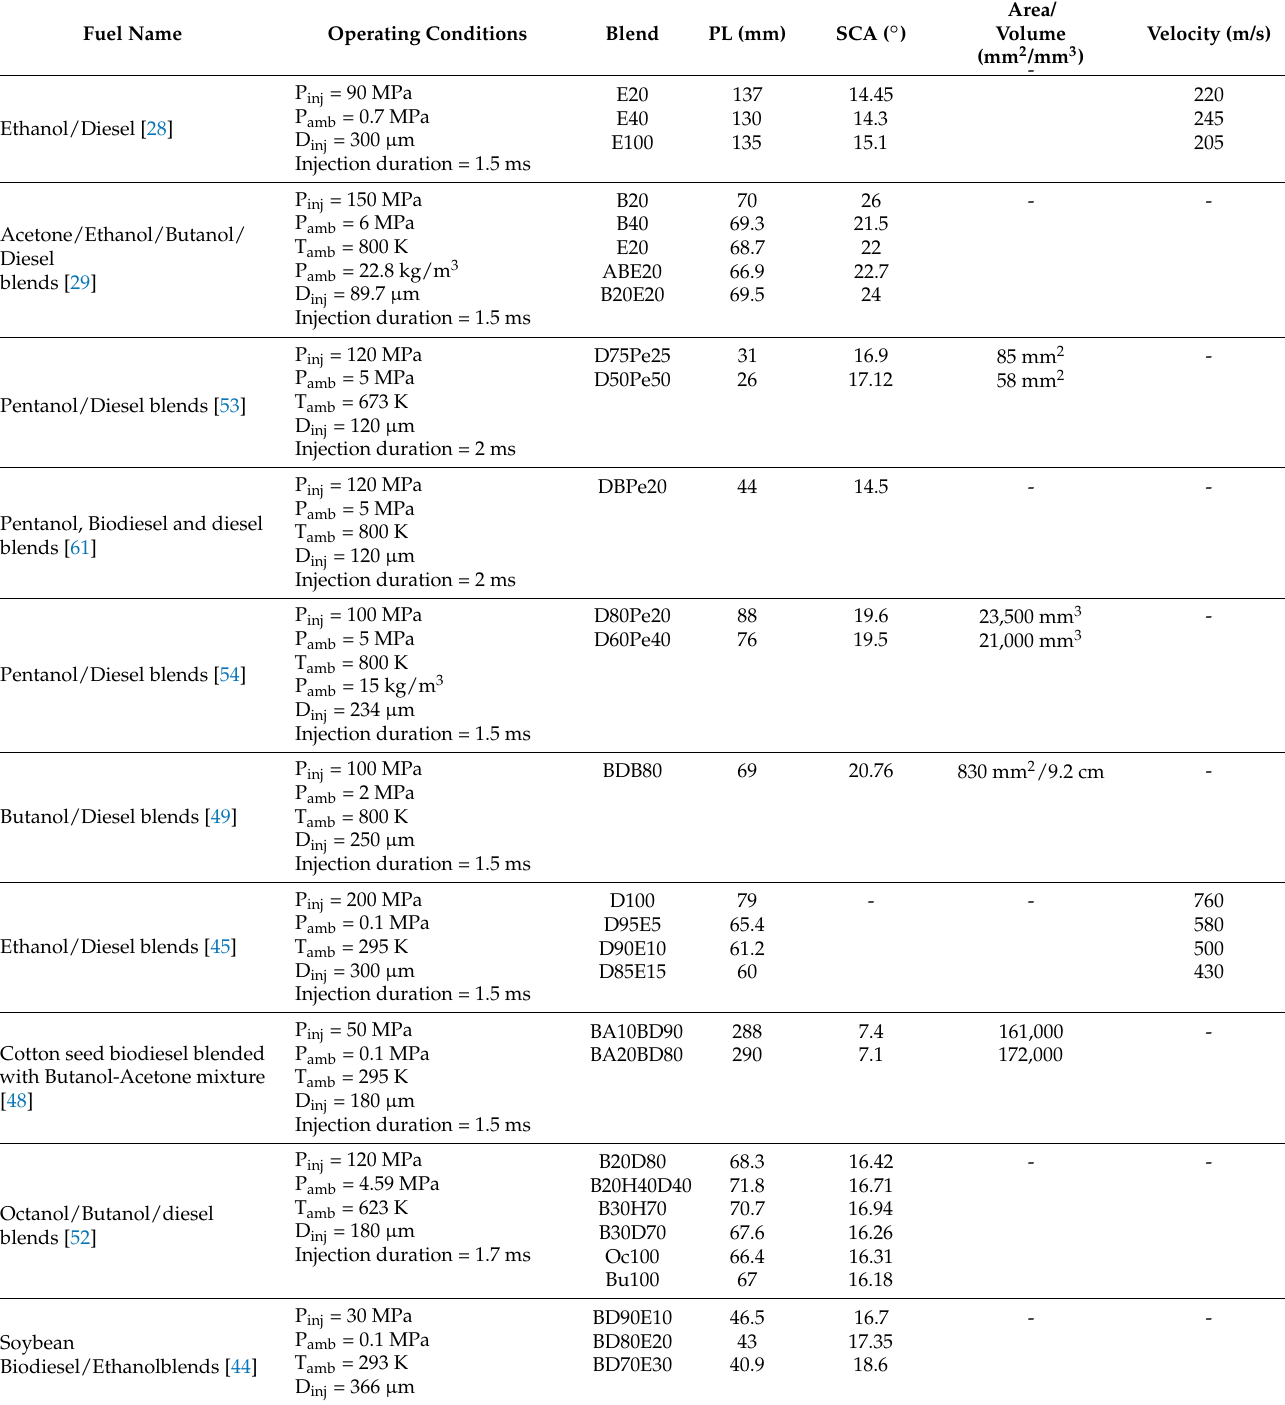
Table 2. Summary of spray properties with alcohol